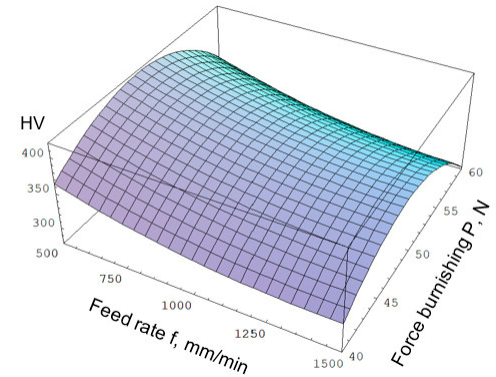
Figure 12. Plot of the regression functions of microhardness.